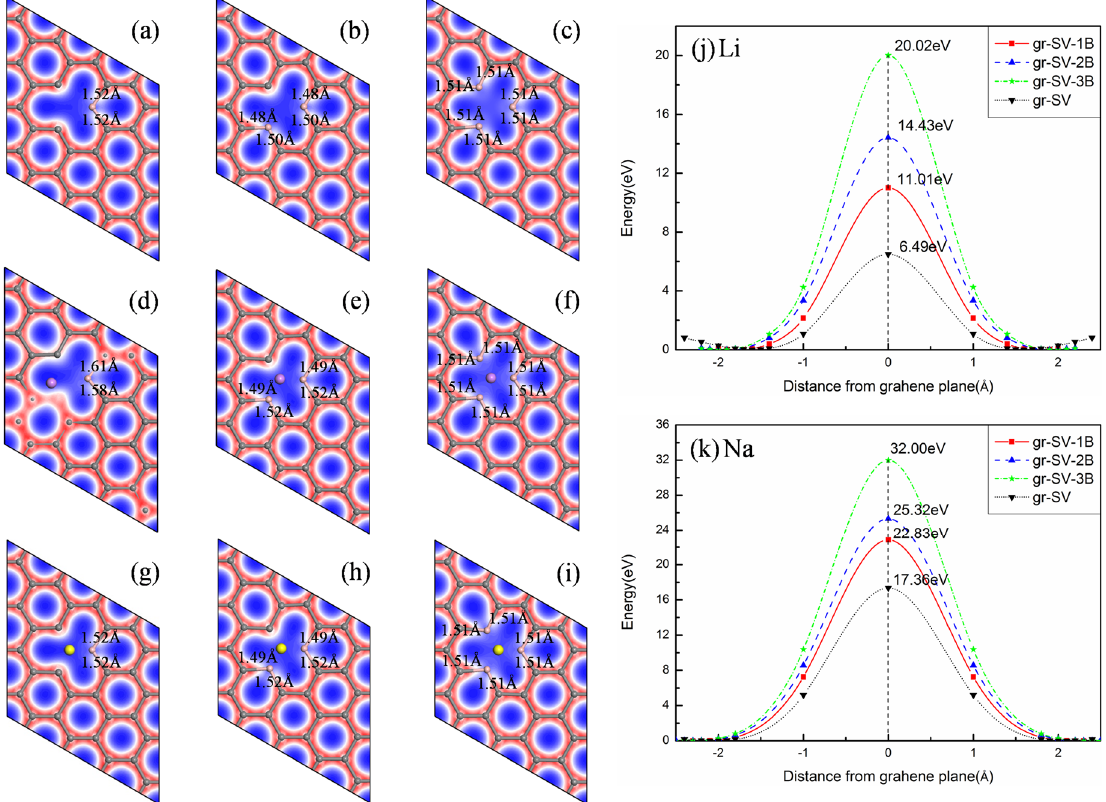
Figure 5. Distribution of the total electronic charge density for graphene with SV doped by: ( a ) one B; ( b ) two B; ( c ) three B; ( d ) one B with Li; ( e ) two B with Li; ( f ) three B with Li; ( g ) one B with Na; ( h ) two B with Na; ( i ) three B with Na; and ( j ) and ( k ) corresponding diffusion barriers for Li and Na.